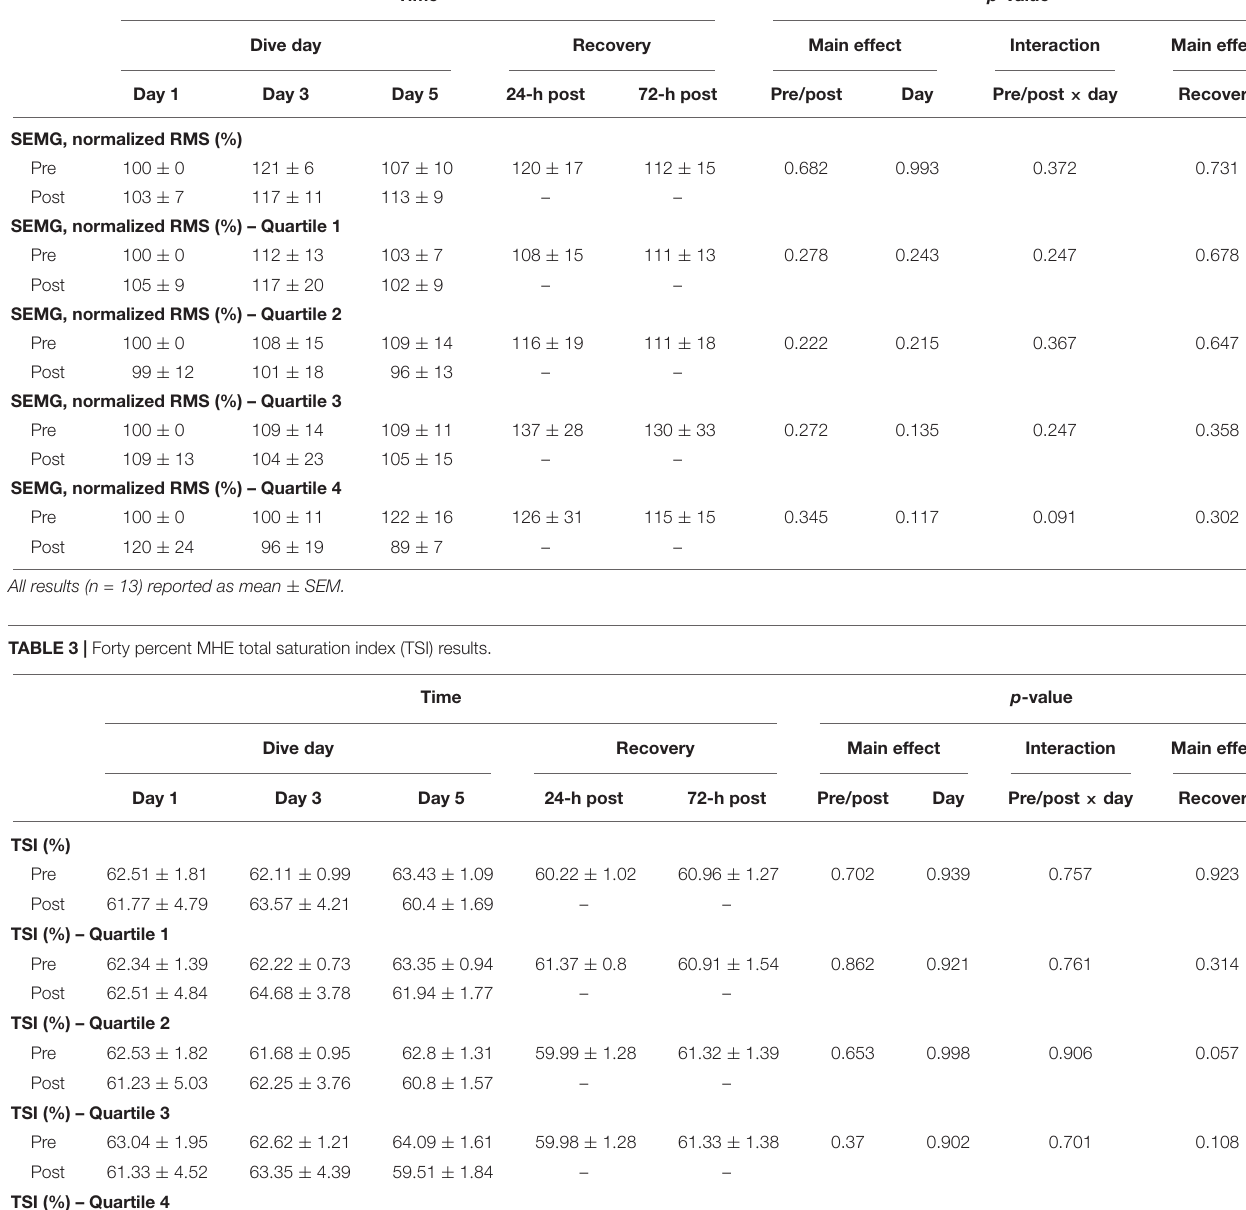
TABLE 2 | Forty percent maximum handgrip endurance (MHE) surface electromyography (SEMG) results. Time